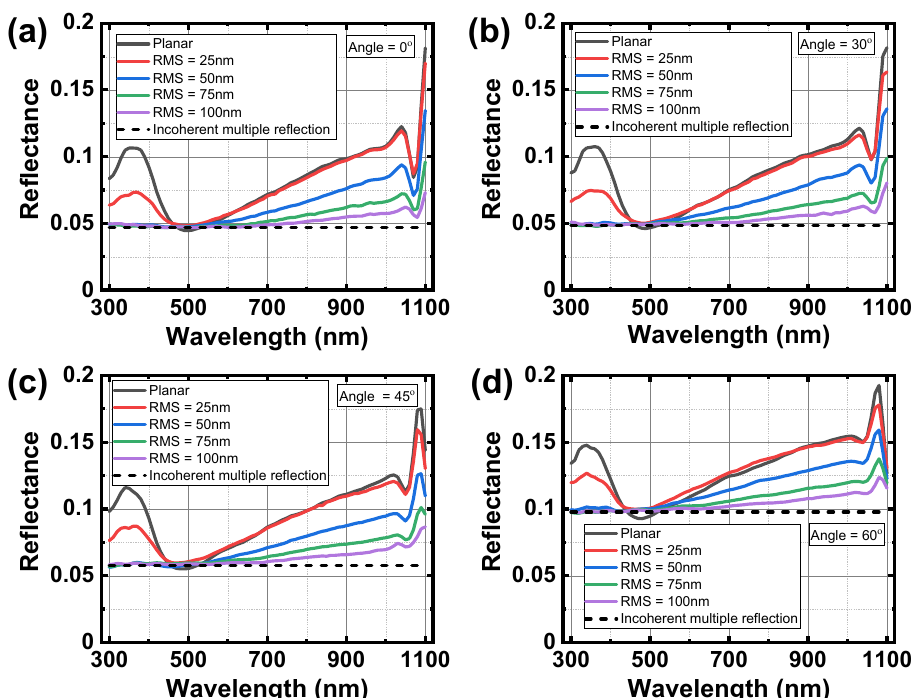
Fresnel equation, which depends on the refraction angle and light polarization [15]. The black dotted lines in Figure 8 show the calculated values of the incidence-angle-dependent reflectance of the incoherent multiple optical reflections, which are well matched with the minimum reflectance values of the surface-textured CIGS solar cell with σ RMS = 100 nm.